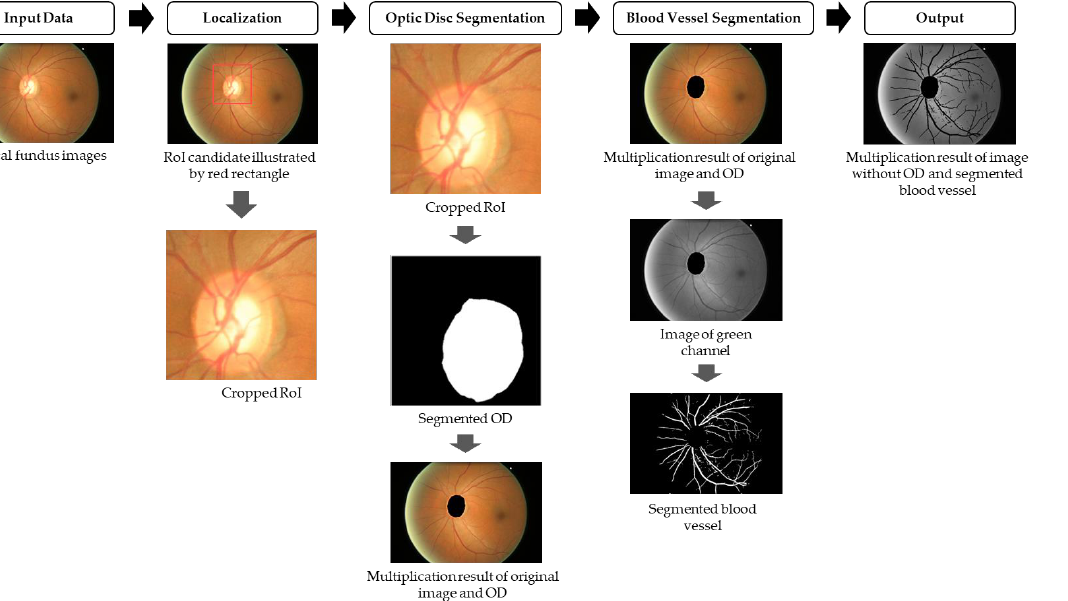
Figure 12. Result of a pre-processing step including localization step, OD segmentation, and blood vessel segmentation.